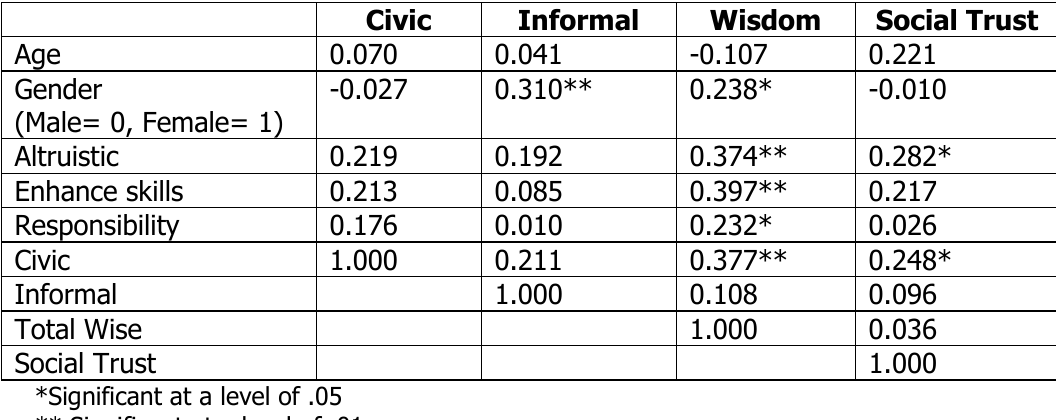
Correlations of Demographics, Motivation, Social Capital and Wisdom. Civic Informal Wisdom